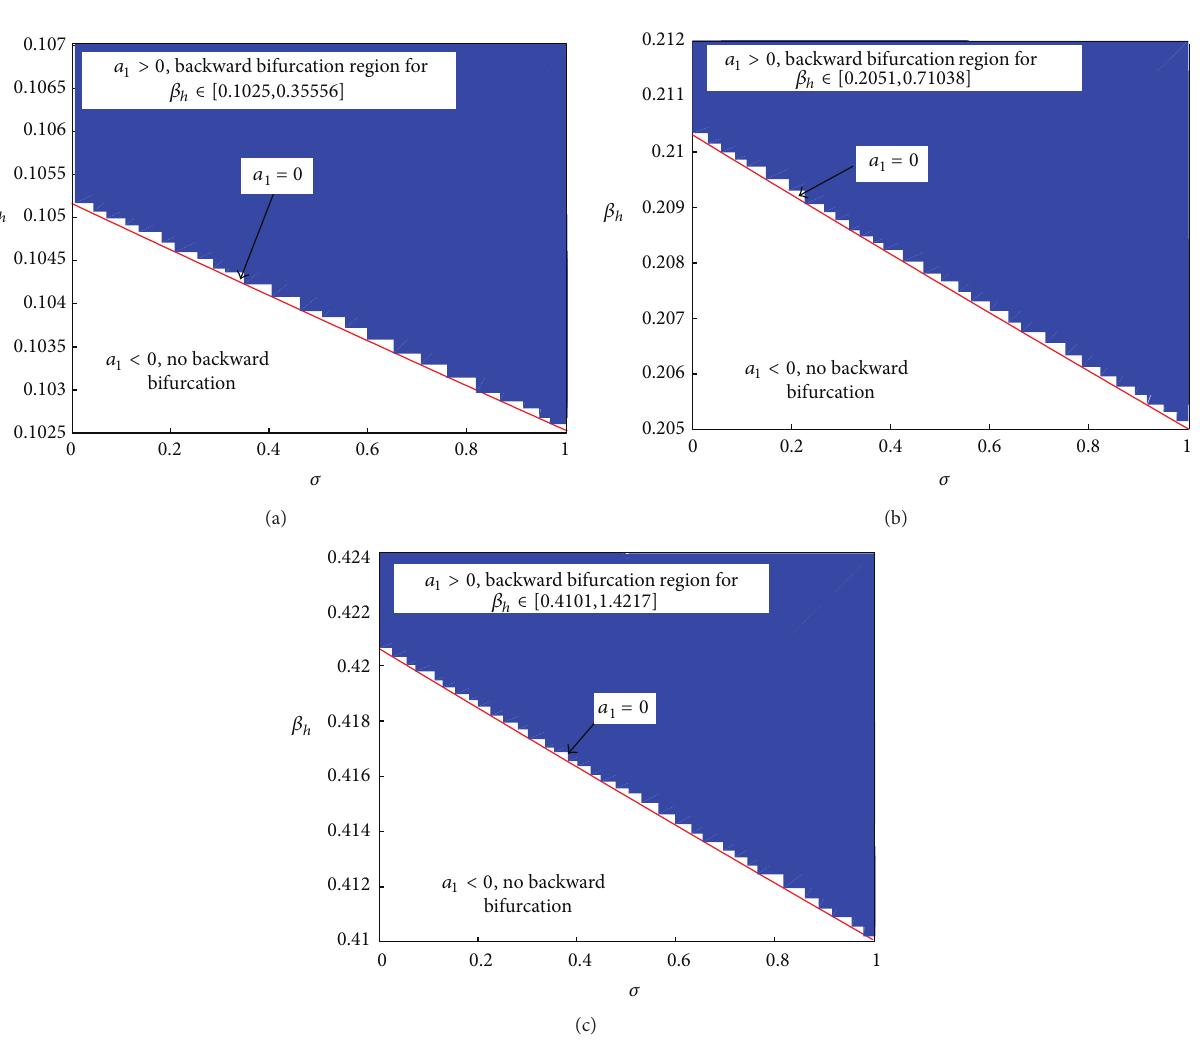
𝛽 ∈ [0.1025, 0.35556]) , (b) 𝜇 = 0.1, ℜ = 0.00035113 (backward bifurcation region for 𝛽 ℎ is ℎ 𝑣 0